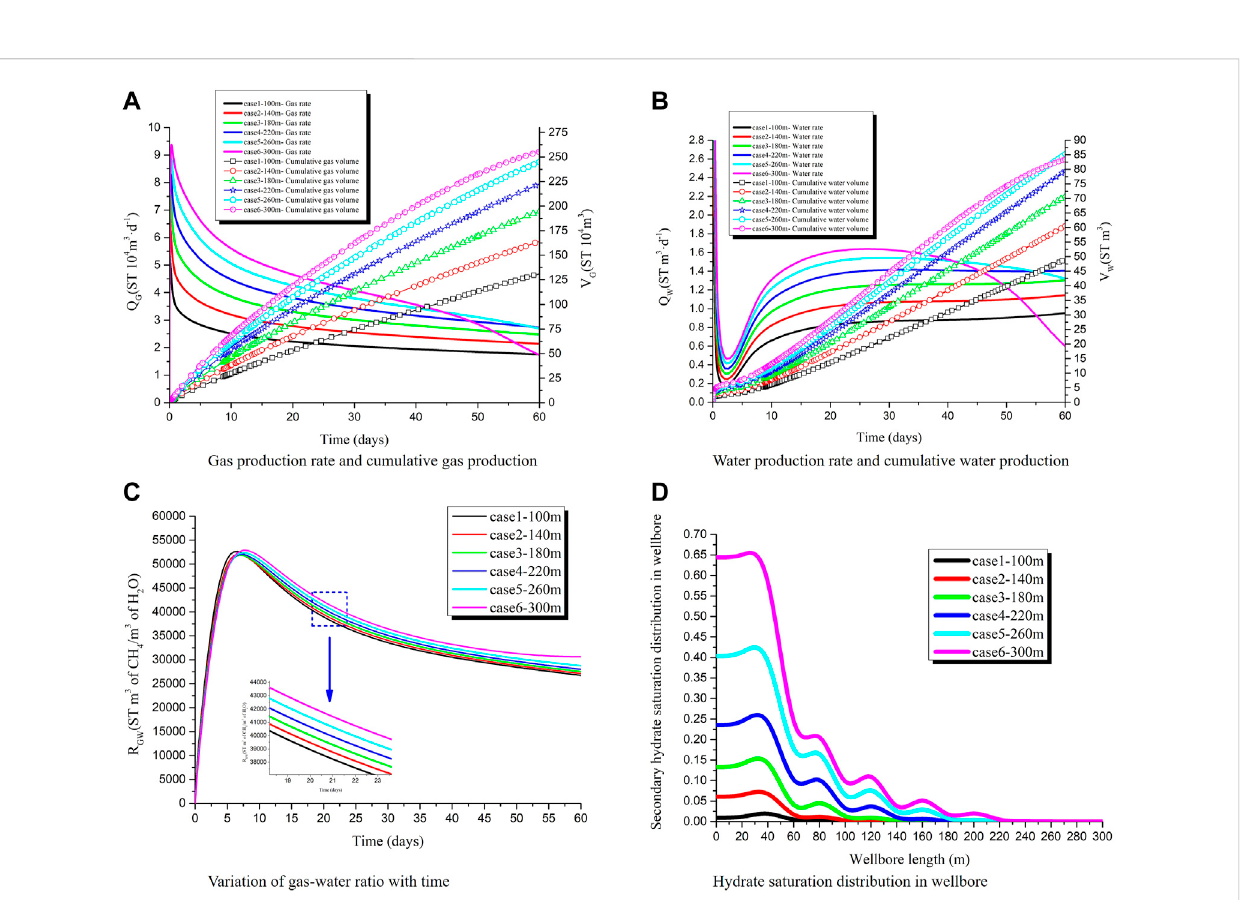
FIGURE 7 Gasproductionrateandcumulativegasproduction (A) ,waterproductionrateandcumulativewaterproduction (B) ,variationofgas-waterratiowith time (C) , and hydrate saturation distribution in wellbore (D) after 60 days of depressurization production with different horizontal well section